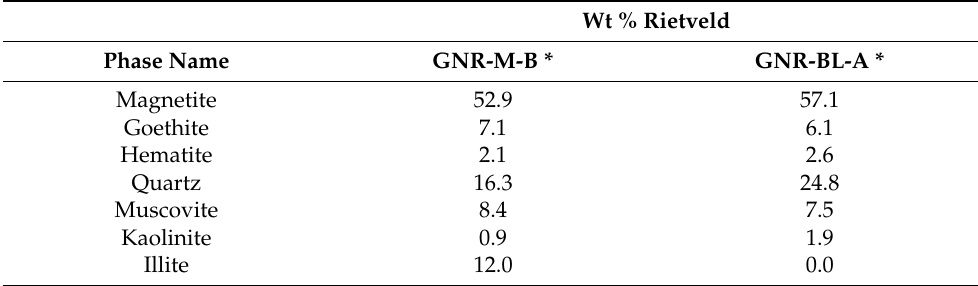
Table 2. Rietveld analysis of the solid phase of long-term crude cultures using synthetic Fe(III) oxide as the Fe(III) source, which became black and magnetic after 170